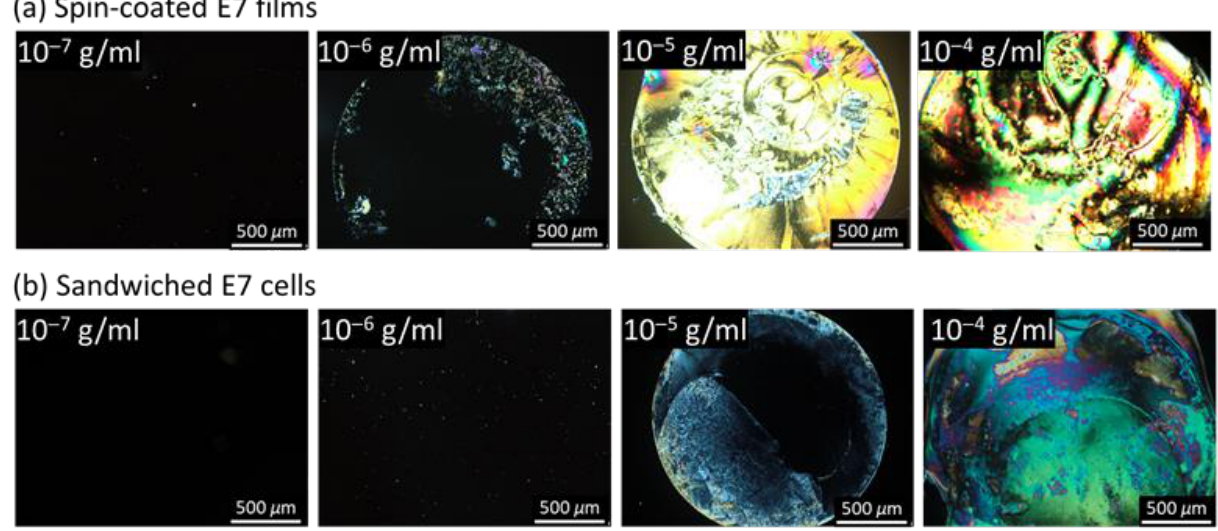
Figure 3. Polarized optical textures of E7 in spin-coated films and LC cells in the presence of BSA. The nematic LC E7 was ( a ) spin-coated as a thin film on a DMOAP-coated glass substrate or ( b ) sandwiched between two glass substrates in an LC cell at various BSA concentrations ranging from 10 −7 to 10 −4 g/mL. Scale bar, 500 μ m.